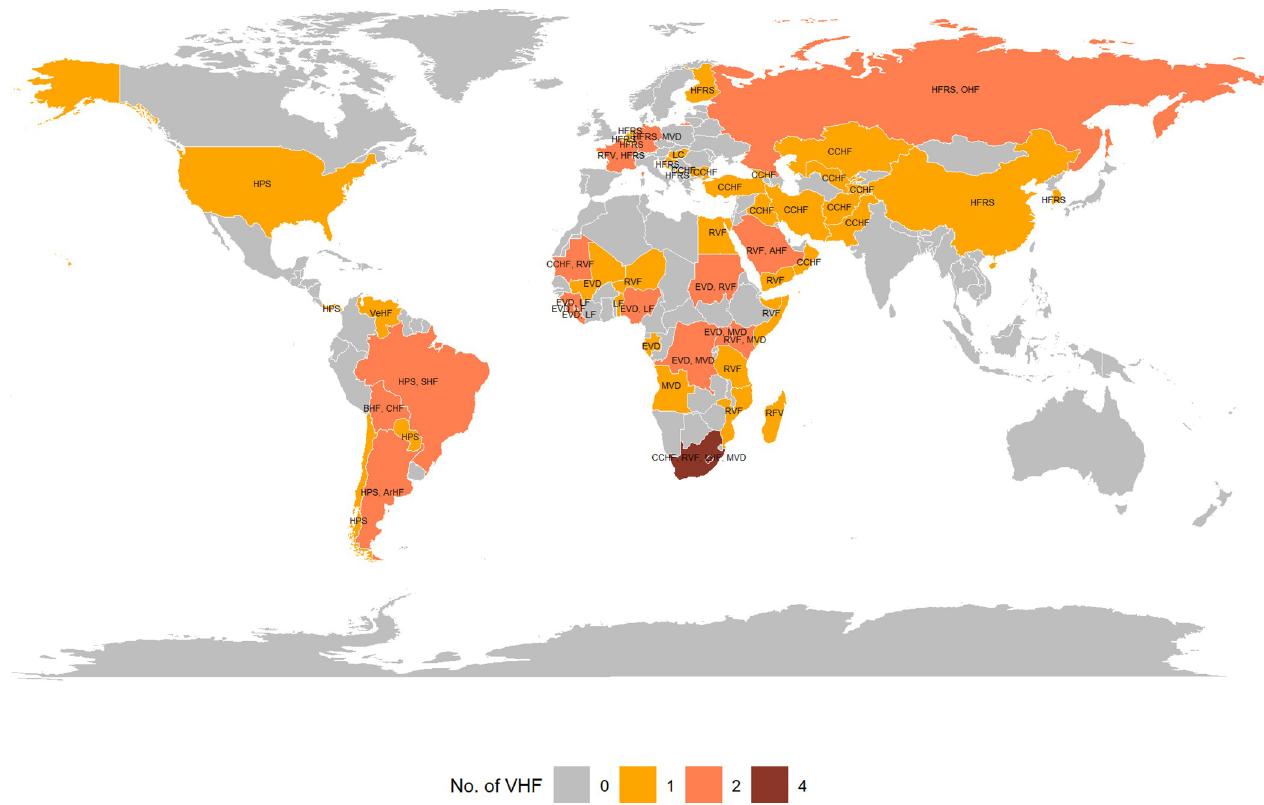
Fig 2. Worldwide distribution of VHF. The color denotes the number of VHF with at least one outbreak reported by country and the acronyms denote the names of the VHFs. Note: AHF, Alkhurma hemorrhagic fever; ArHF, Argentine hemorrhagic fever; BHF, Bolivian hemorrhagic fever; CHF, Chapare hemorrhagic fever; CCHF, Crimean-Congo hemorrhagic fever; EVD, Ebola Virus Disease; HPS, Hantavirus Pulmonary Syndrome; HFRS, Hemorrhagic fever with renal syndrome; LF, Lassa fever; LHF, Lujo hemorrhagic fever; MVD, Marburg virus disease; OHF, Omsk hemorrhagic fever; RVF, Rift Valley fever; SHF, Sabia hemorrhagic fever; VeHF, Venezuelan hemorrhagic fever. Maps were generated with the ‘maps’ R package using data from the Natural Earth Project (the 1:50m resolution version).